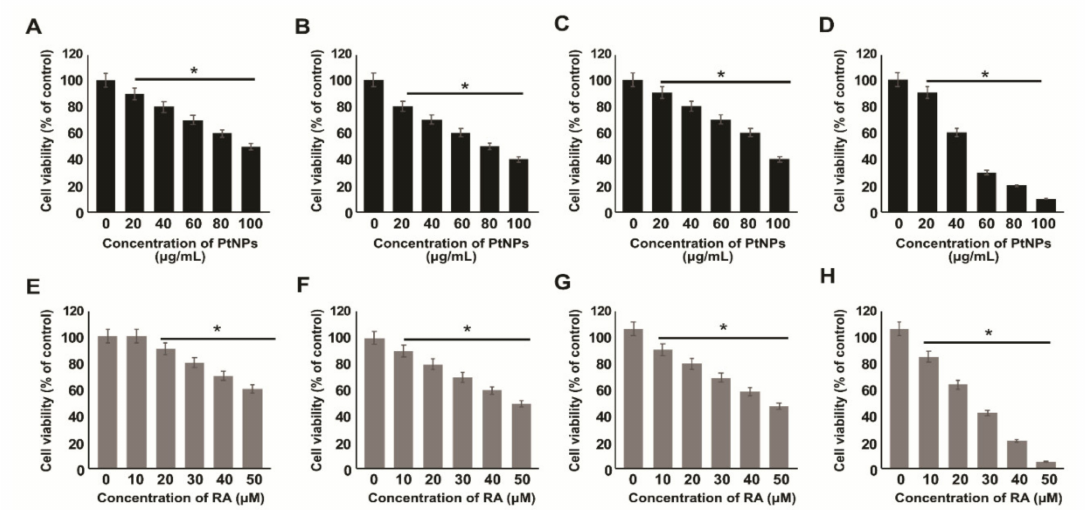
Figure 2. Determination of sensitivity of various type of cancer cells to PtNPs and retinoic acid (RA). Cell viability was determined in various types of cancer cells, including human adenocarcinoma cells ( A , E ), human breast cancer cells ( B , F ), human prostate cancer cells ( C , G ), and human neuroblastoma cells ( D , H ) treated with various concentrations of PtNPs (20–100 µ g / mL) ( A – D ) or RA (10–50 µ M) ( E – H ) for 24 h. The results are expressed as mean ± standard deviation of three independent